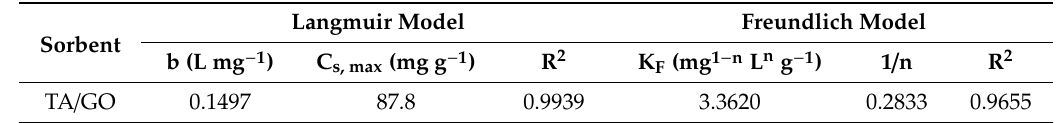
Table 3. Parameters of the Langmuir and Freundlich models for U(VI) ion sorption on TA / GO composites.